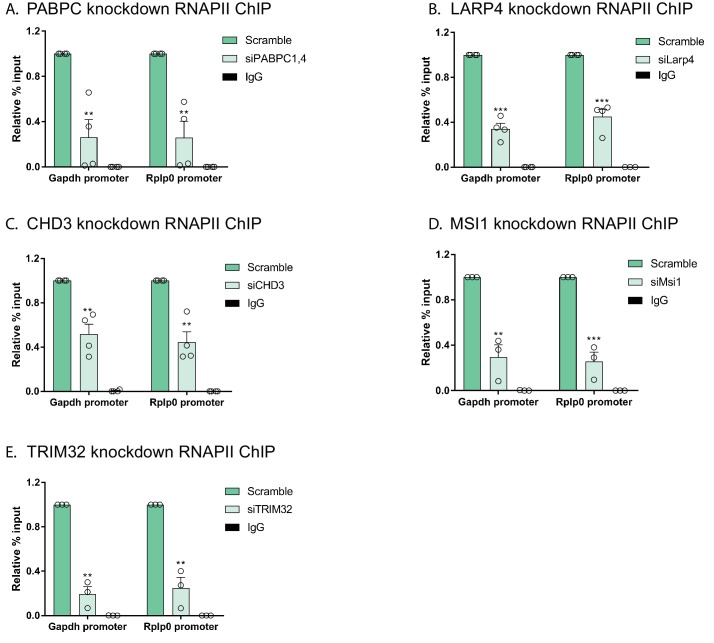
Effects of depleting PABPC, LARP4, CHD3, MSI1 and TRIM32 on RNAPII promoter occupancy.(A–E) HEK293T cells were treated with siRNAs targeting PABPC1 and PABPC4 (A), LARP4 (B), CHD3 (C), MSI1 (D), or TRIM32 (E), and subjected to ChIP using antibodies to RNAPII or IgG. Purified chromatin was quantified by qPCR. All graphs display individual biological replicates as dots, with the mean and SEM. Statistical significance was determined using Student’s t test *p<0.05 **p<0.005 ***p<0.0005.